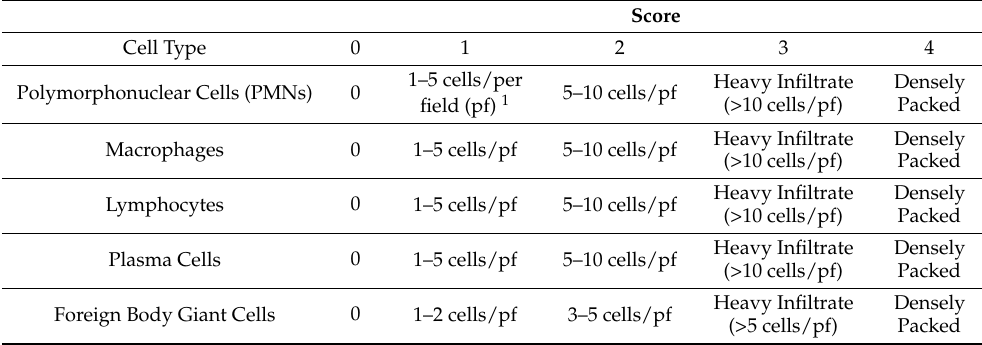
Table 3. Scoring Method for Inflammatory